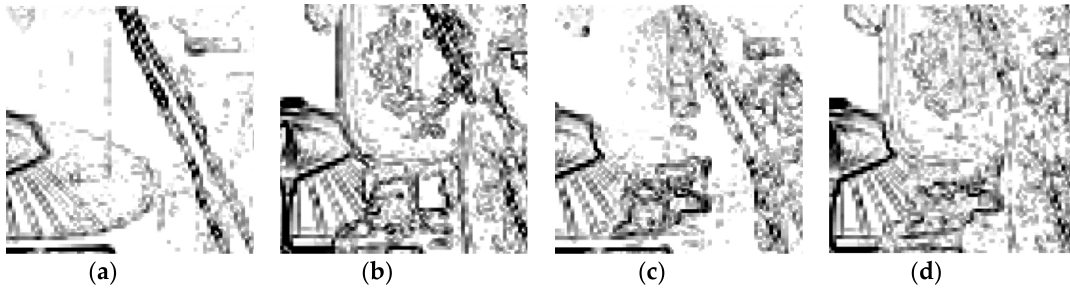
Figure 9. Local details of the edge extraction result in Figure 8: ( a ) original fused transparent visualization, ( b ) lightness adjustment only, ( c ) color enhancement only, and ( d ) improved fused transparent visualization by the proposed method.